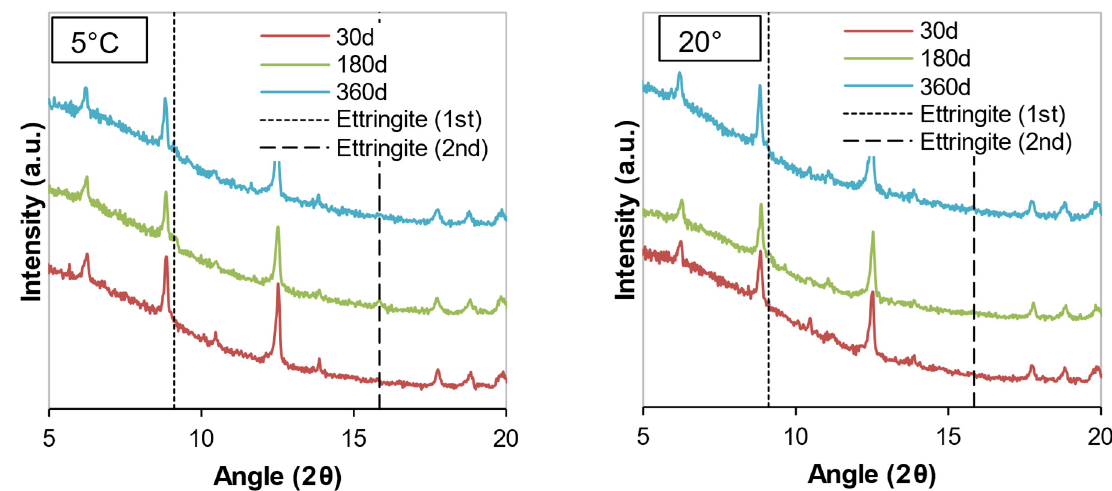
Figure 14. Diffractograms of S + C + W3 at different temperatures.